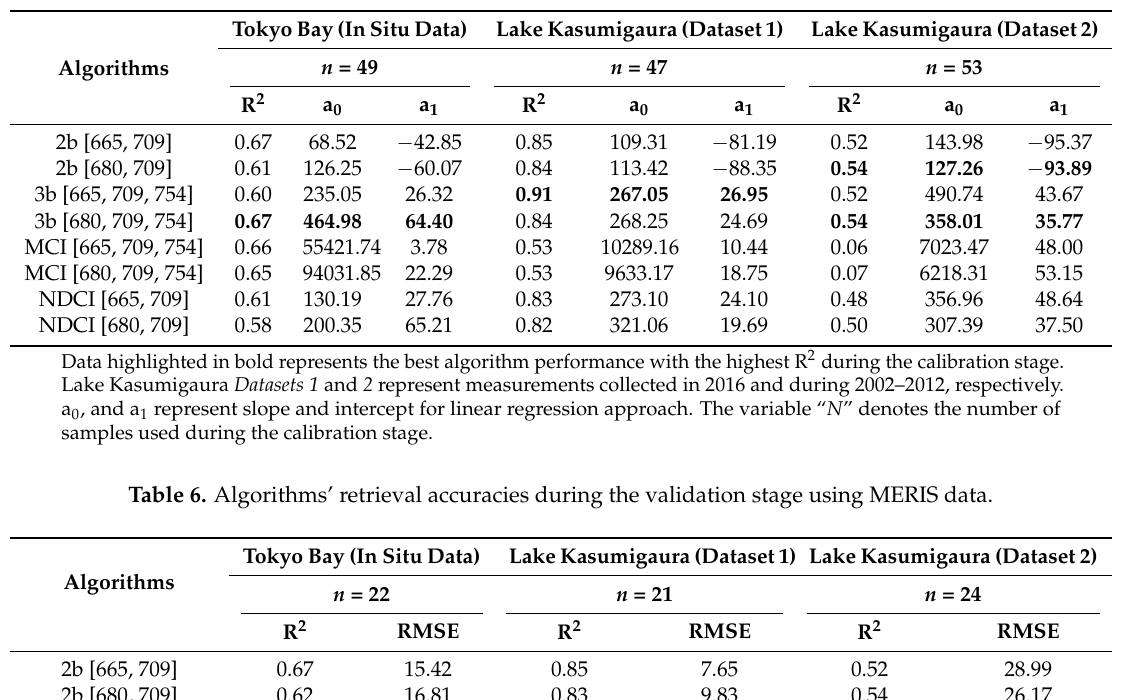
Table 5. Algorithms’ evaluation during the calibrations stage using Medium Resolution Imaging Spectrometer (MERIS) data.